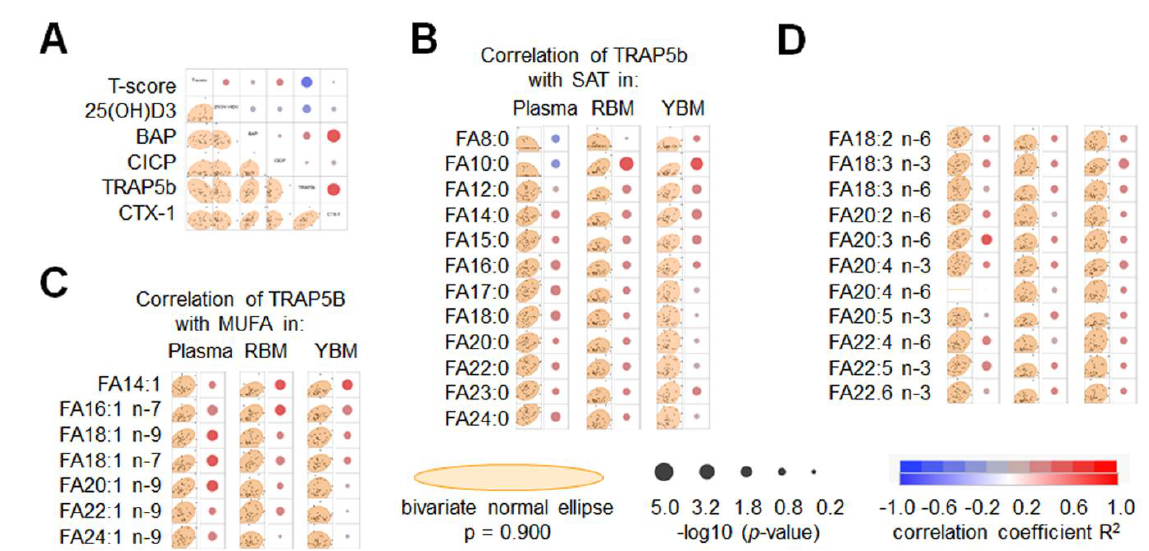
Figure 5: Correlation of the specific bone markers in the plasma with age-adjusted bone mineral density (T-score) and fatty acid composition. ( A ) Multivariate analysis of the measured bone markers in the plasma and the corresponding T-scores. Summary of the correlations of the TRAP5b levels measured in the plasma with ( B ) the individual saturated fatty acids (SAT), ( C ) mono-unsaturated fatty acids (MUFA), and ( D ) poly-unsaturated fatty acids (PUFA) in the plasma, red bone marrow (RBM), and yellow bone marrow (YBM). Correlations are displayed as bivariate fitted normal ellipses ( p = 0.90) with indi- vidual data points and summarized as colored significance